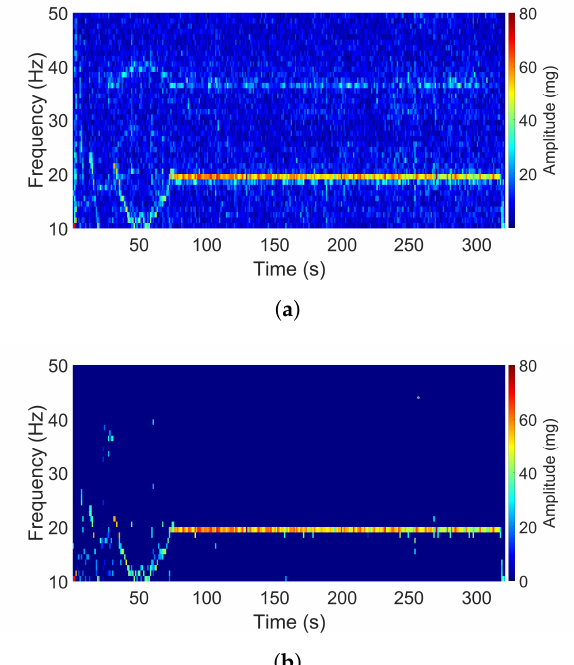
Figure 7. Spectrogram of the car-in-highway signal (X direction): ( a ) Original. ( b )